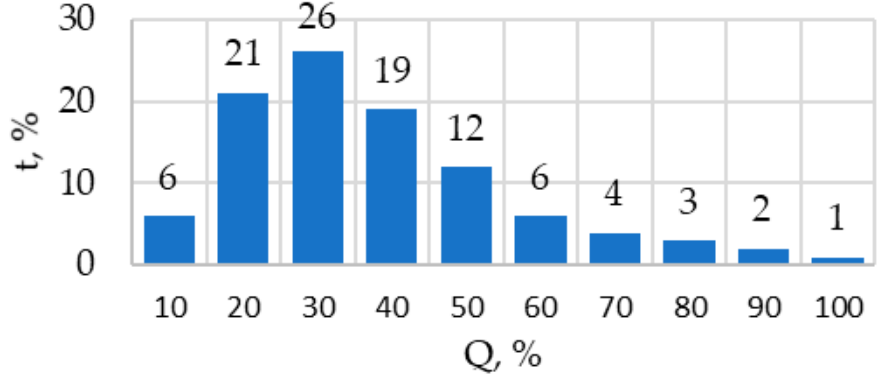
Figure 7. Time vs. Flow chart.